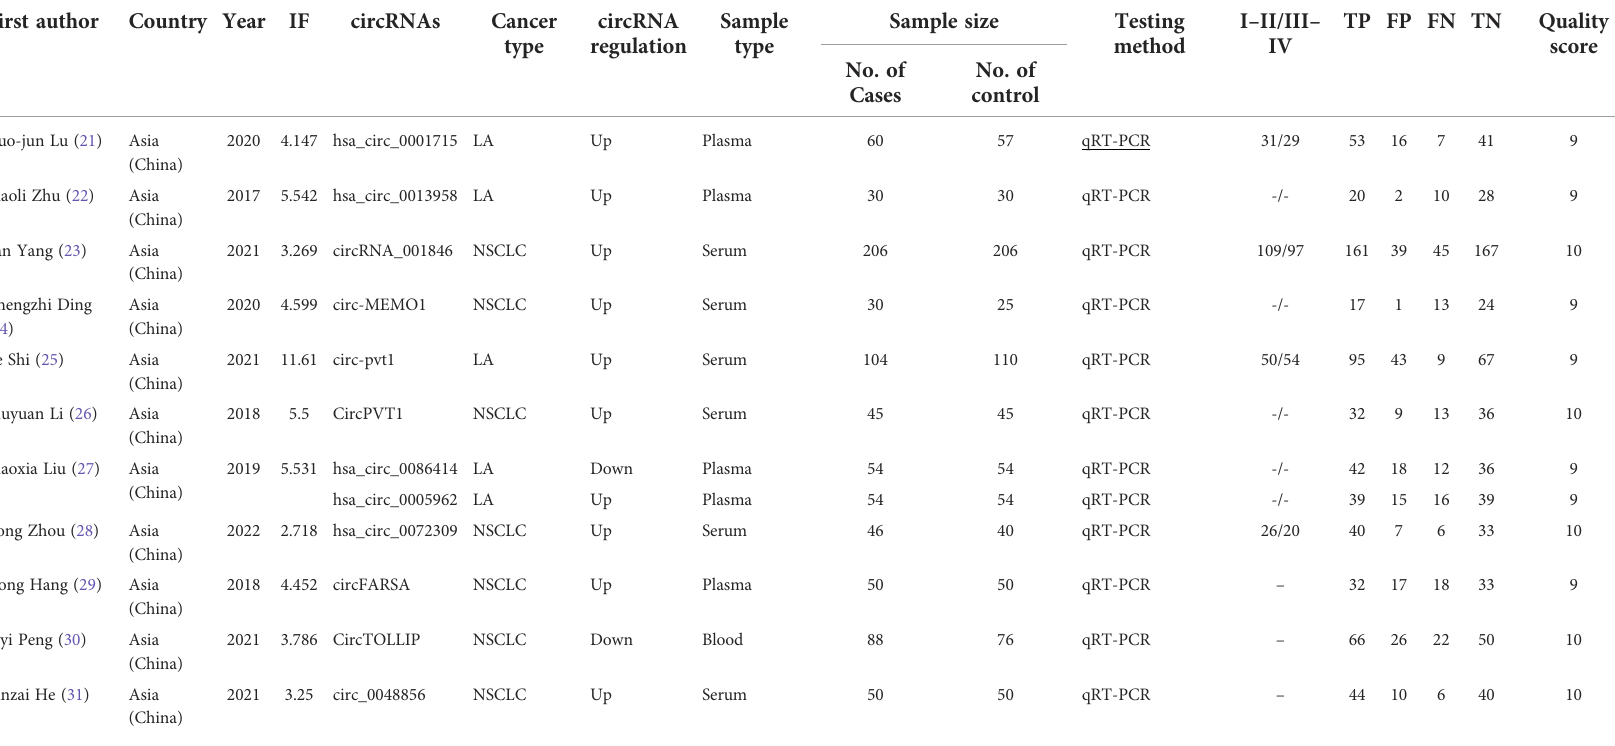
TABLE 1 Characteristics of circRNAs and quality of included studies in